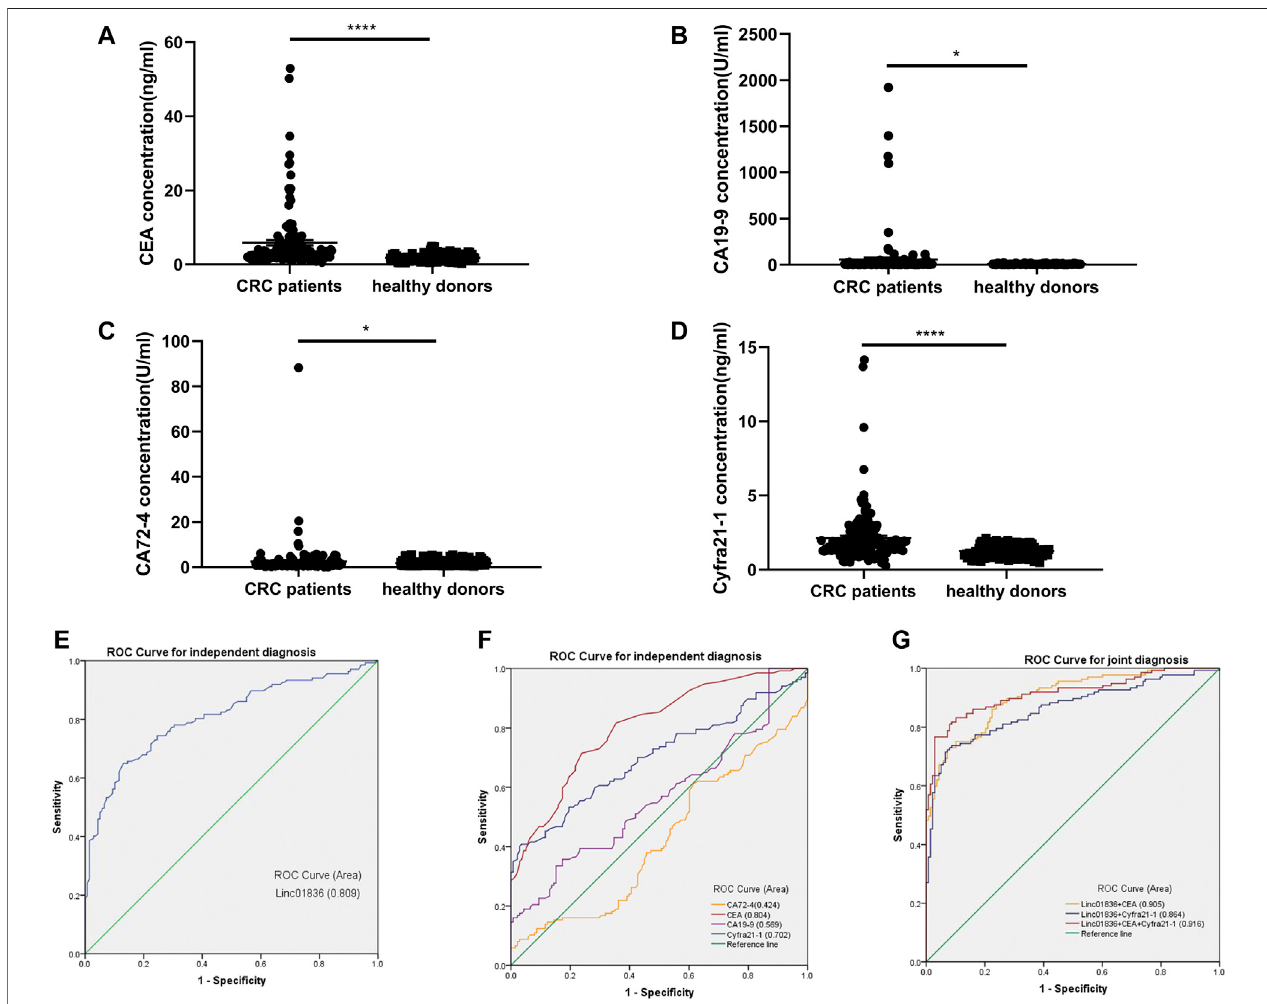
FIGURE4| DiagnosticvalueofLinc01836andothercommonlyusedtumorbiomarkersforCRC. (A – D) TheexpressionlevelsofserumCEA,CA19-9,CA72-4,and Cyfra21-1 in CRC patients ( n = 137) and healthy donors ( n = 138) (E,F) Receiver operating characteristic (ROC) curve analysis of Linc01836, CEA, CA19-9, CA72-4 ,and Cyfra21-1 in independent diagnosis of CRC patients and healthy donors. (G) ROC curve analysis of Linc01836, CEA, and Cyfra21-1 in joint diagnosis of CRC patients and healthy donors. * p < 0.05, ** p < 0.01, *** p < 0.001, **** p < 0.0001, NS p > 0.05.